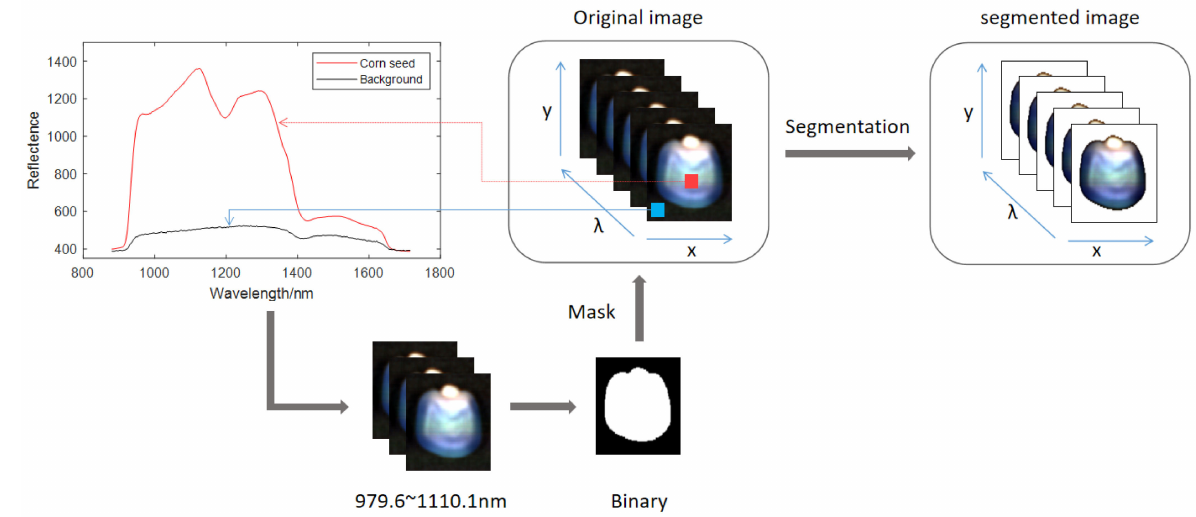
Figure 2. Background segmentation of hyperspectral